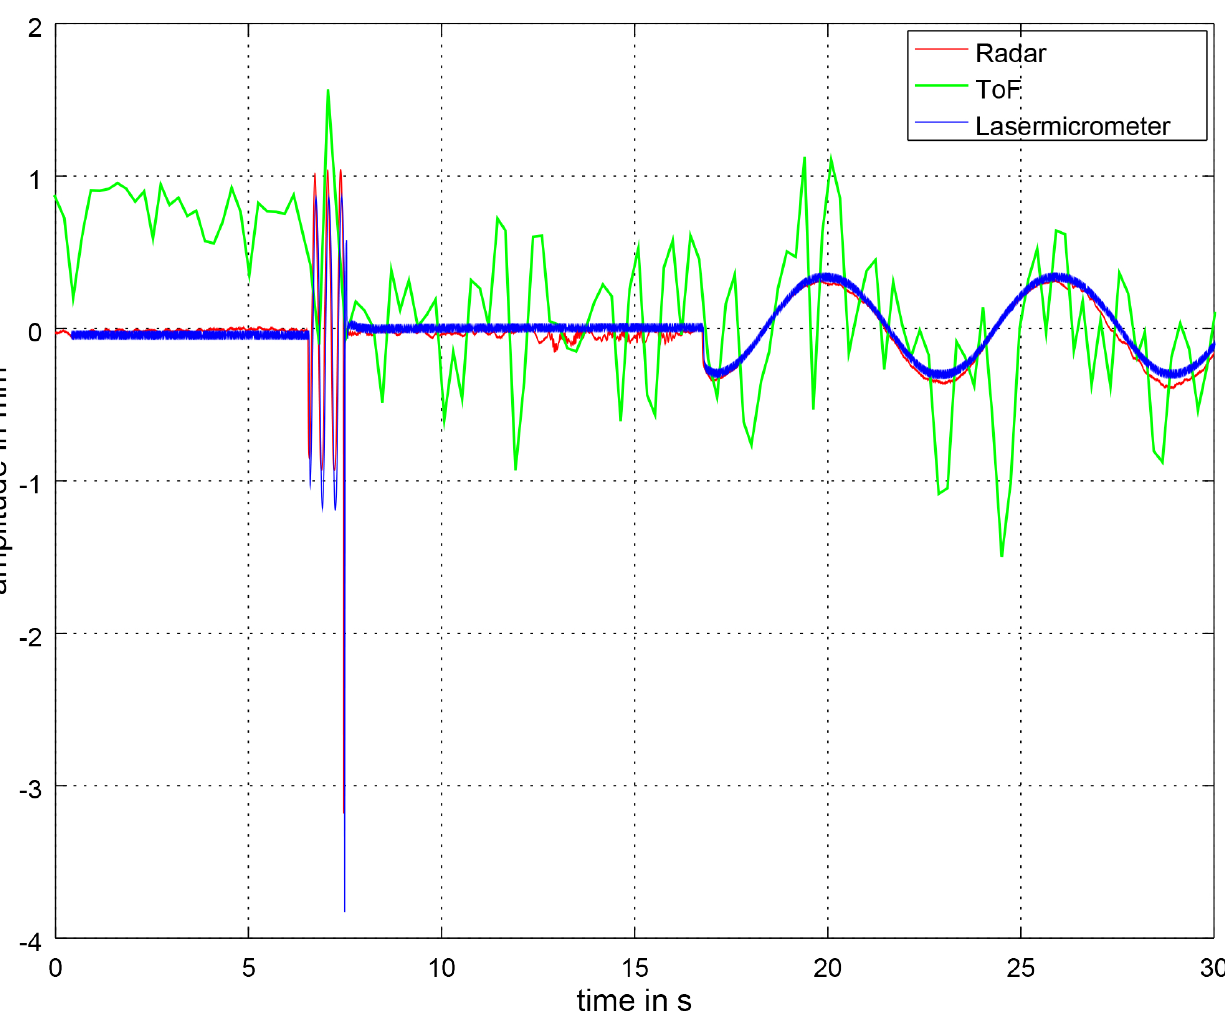
Figure 14. Unfiltered section of the respiratory signal at 10BPM in deep mode measured by the ToF camera, the radar sensor and the laser micrometer. In the context of the ToF camera, unfiltered means that the Savitzky–Golay filter has not been applied yet. At the beginning, the synchronization signal can be seen. The ToF camera signal is very noisy and has high amplitude jumps. In comparison, the radar and laser micrometer signals are very